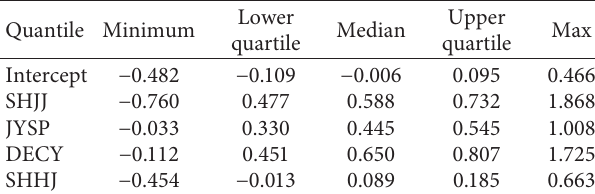
Table 3: GTWR model test